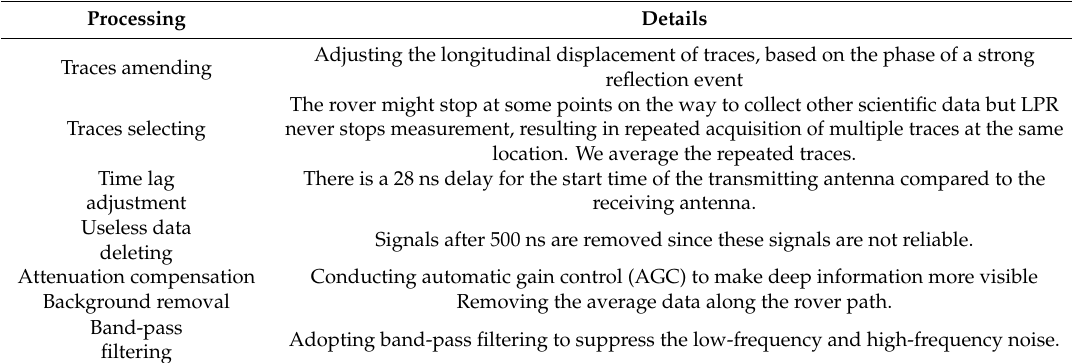
Table 2. Details of data processing.